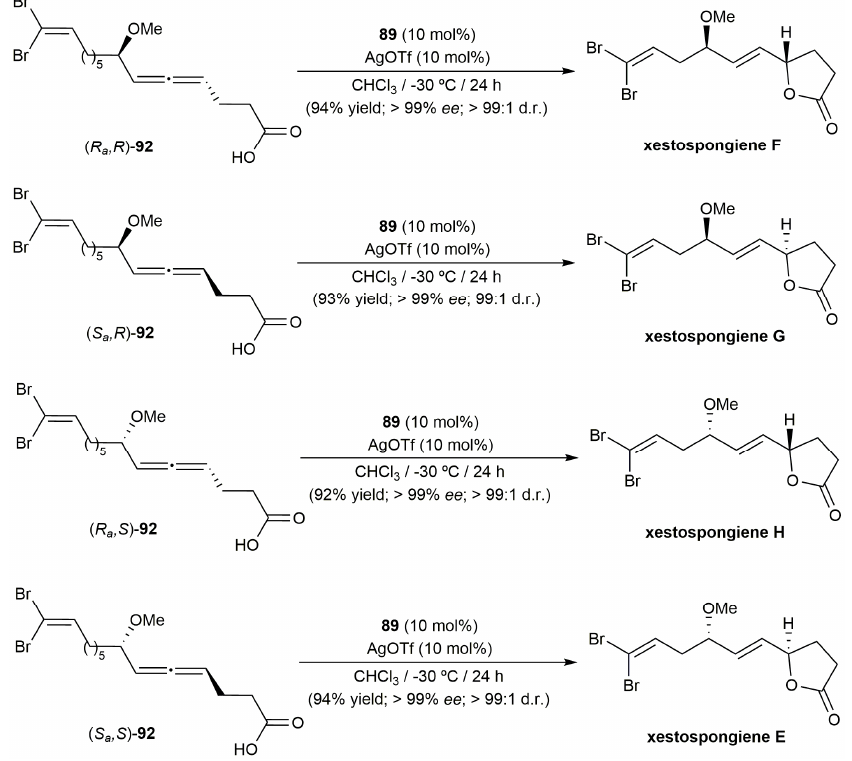
Figure 11. Structure of some naturally occurring γ -alkyl-substituted γ